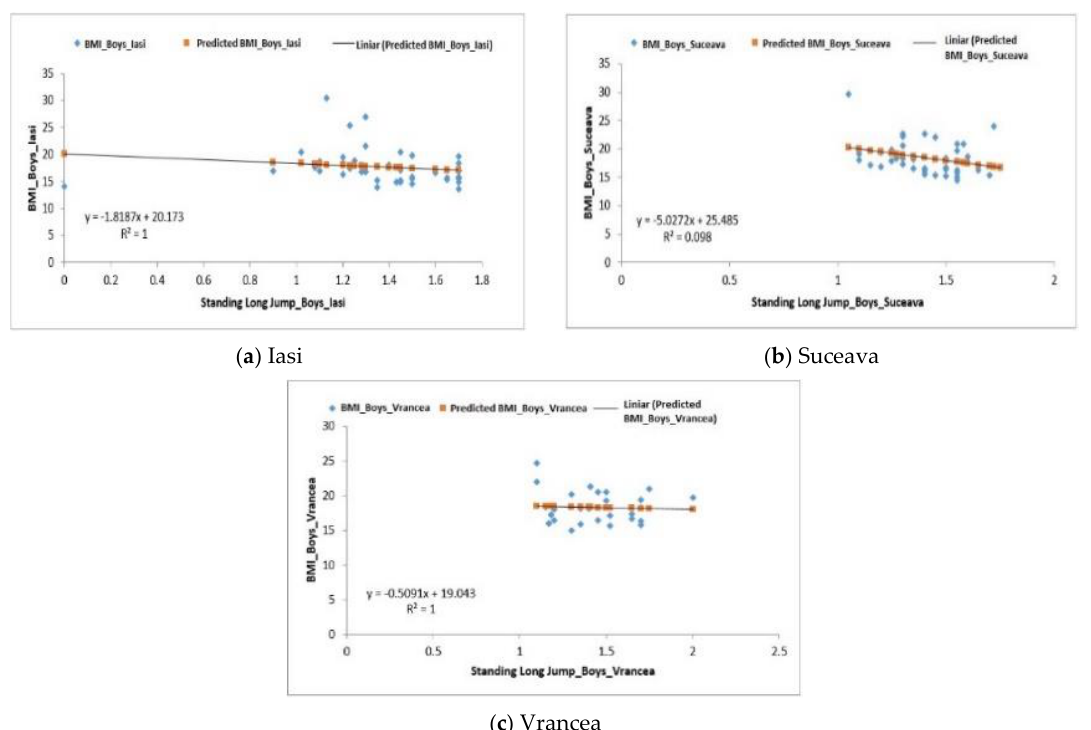
Figure 5. Relationship between the BMI and the standing long jump test for the boys in the three regions.